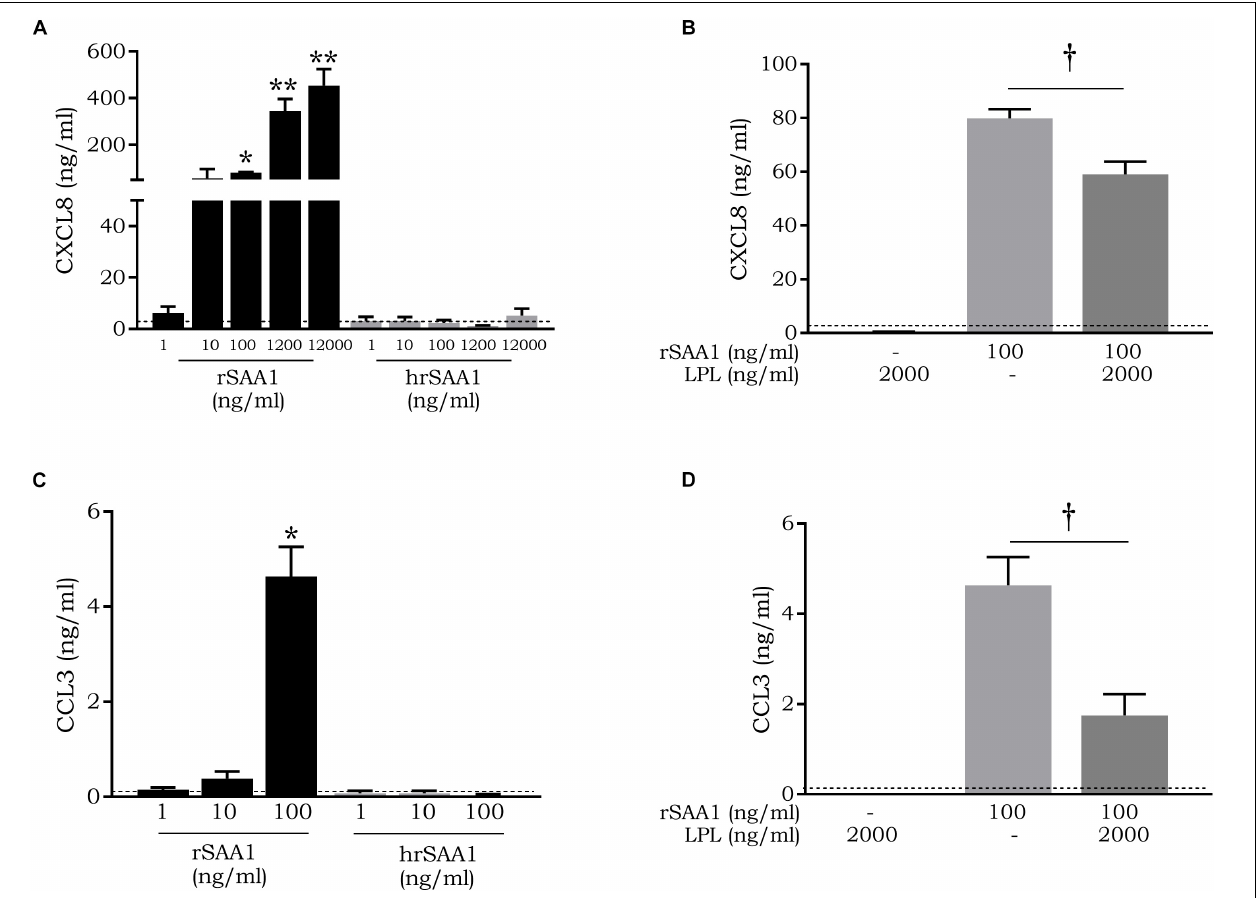
FIGURE 3 | hrSAA1 does not induce chemokine expression in CD14 + monocytes and treatment of rSAA1 with LPL diminishes activity. (A,C) Freshly isolated monocytes were induced with homogenous rSAA1 (hrSAA1) (1–12000 ng/ml, 0.08–1000 nM) in parallel with rSAA1 (1–12000 ng/ml, 0.08–1000 nM). (B,D) rSAA1 (100 ng/ml, 8 nM) was pre-incubated with LPL (2000 ng/ml) for 4 h prior to stimulation of monocytes. Following an incubation period of 24 h, cell supernatants were collected and CXCL8 and CCL3 expression was determined via specific ELISAs. Expression in unstimulated cells is indicated by a dashed line (---). Results are represented as the mean chemokine concentration + SEM and are derived from four to six independent experiments. Significant upregulation in comparison to control is indicated by asterisks (Mann-Whitney U -test; * p -value < 0.05, ** p -value < 0.01). Significant reduction in inductive capacity following LPL treatment is indicated by a dagger (Mann-Whitney U -test; † p -value <